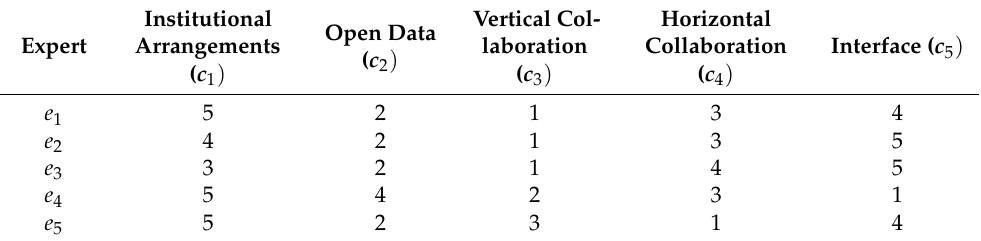
Table 3. Induced values provided by the experts. Induced values are the values that will be used in the induced ordered weighted average (IOWA) operator, instead of a reordering step based on the value of the arguments, in this case, will be based on the induced value determined by the experts, generating a different reordering between the arguments and the weights. Also, the weights used in the Bonferroni induced ordered weighted average (Bon-IOWA) and Bonferroni prioritized induced ordered weighted average (Bon-PIOWA) operators are from Table 1 and for the Bonferroni induced heavy ordered weighted average (Bon-IHOWA) and Bonferroni prioritized induced heavy ordered weighted average (Bon-PIHOWA) operators are from Table